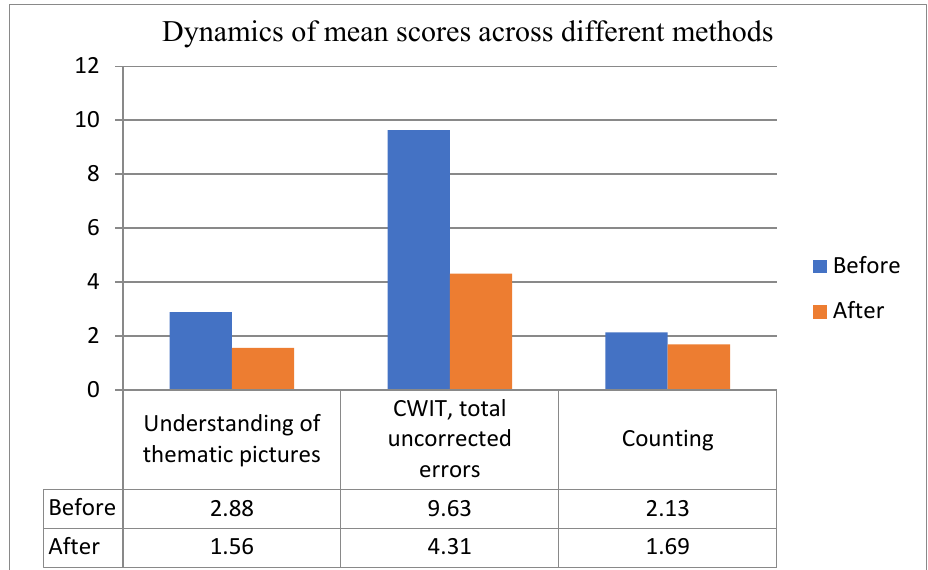
Figure 1. Dynamics of mean scores of methods which differed significantly before and after the training sessions.